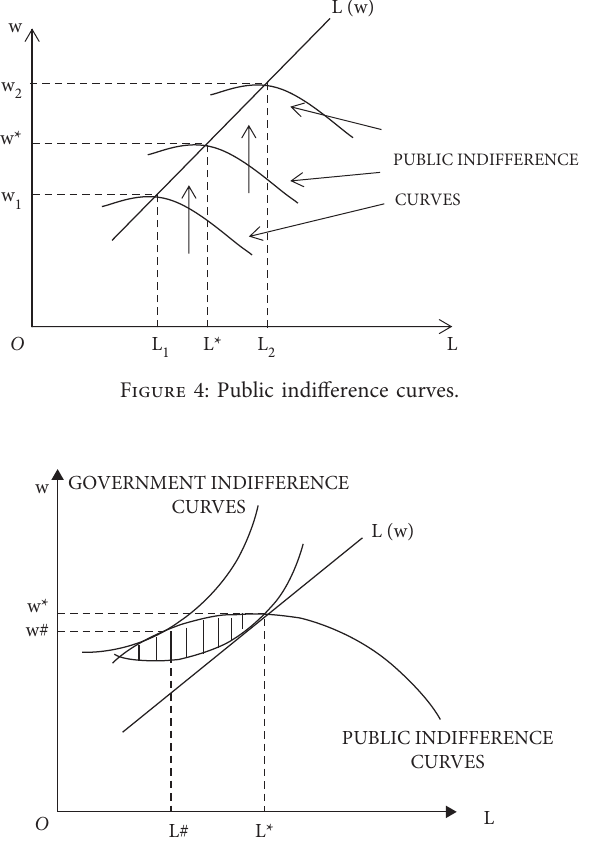
Figure 5: Optimal decision